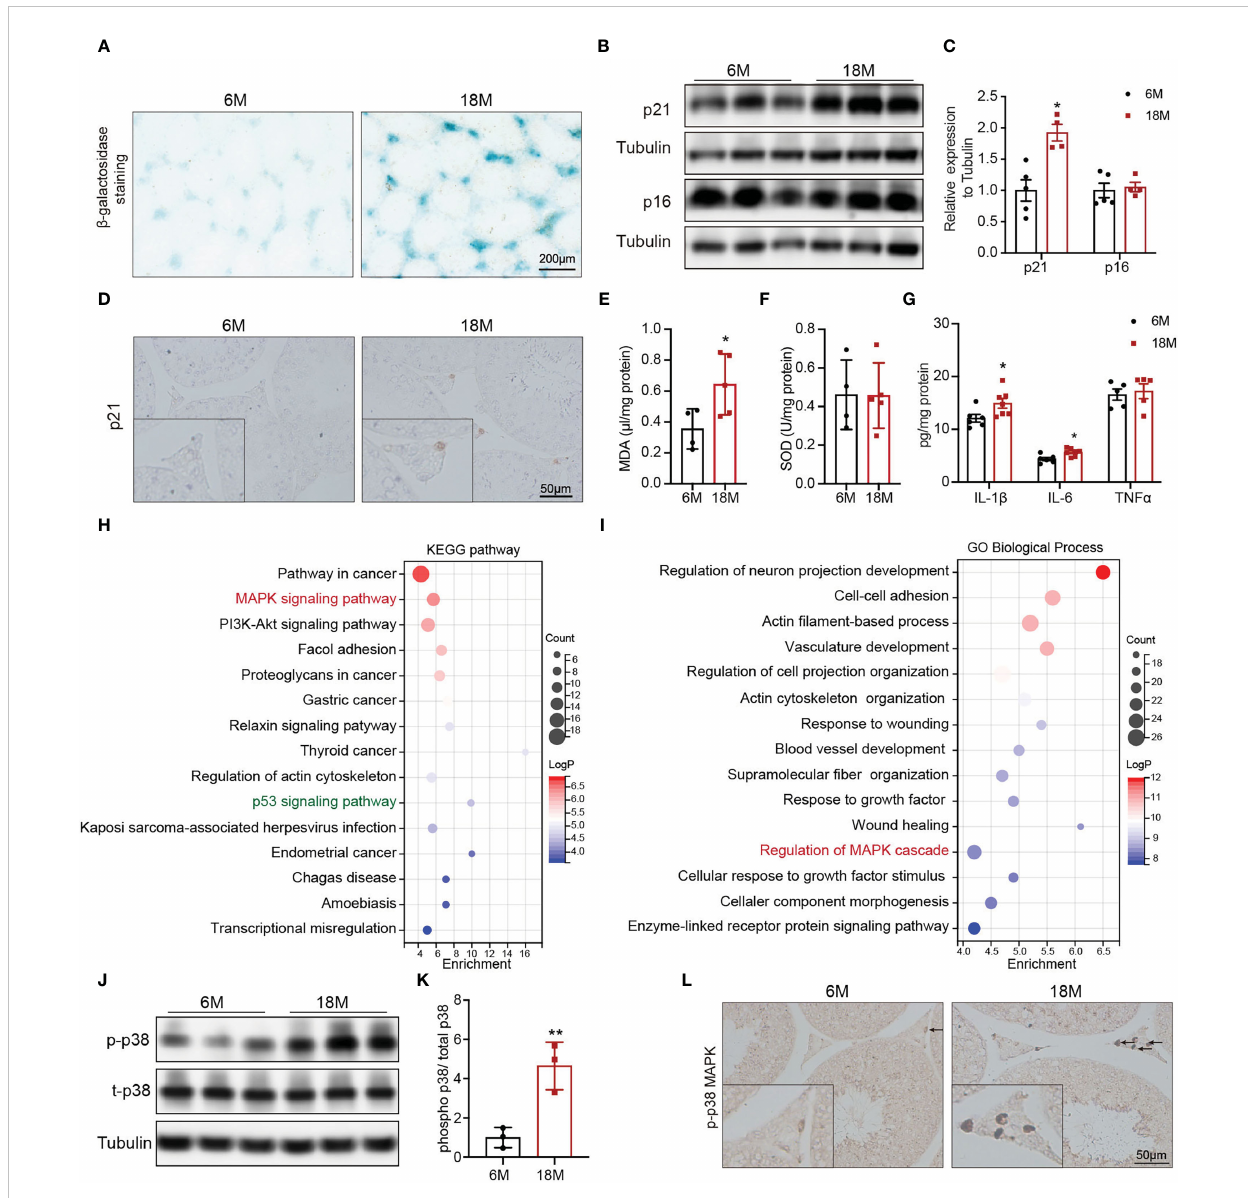
FIGURE 2 Age-related alterations in testes and Leydig cells. (A) Senescence-associated b -galactosidase staining in testes of young and aged mice. (B) The p21 and p16 protein expression in testis of two group mice were analyzed by immunoblot. (C) Quantitative analysis for the protein levels of p21 and p16. (D) The p21 expression and location was analyzed by immunohistochemistry. The levels of MDA (E) , SOD (F) , and in fl ammation factors (G) in the testis tissue of two groups of mice were detected by assay kits. The top 15 KEGG terms (H) and GO terms (I) enriched in the differentially expressed genes in Leydig cells from young and old human testis single-cell RNA sequencing were listed with p value and gene numbers. The p-p38 MAPK protein level in testis of two groups of mice were assessed by immunoblot (J) and IHC staining (L) . (K) Quantitative analysis for protein levels of p- p38 MAPK. *p< 0.05, **p<